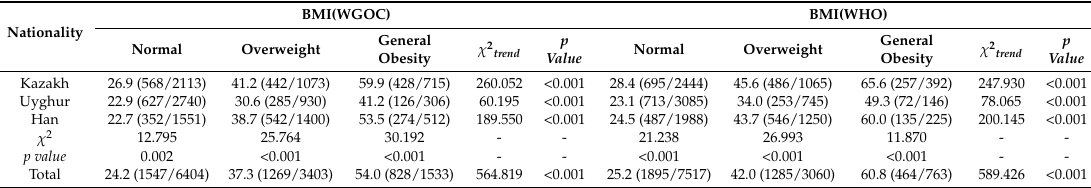
Table 4. Prevalence of hypertension by BMI and nation.